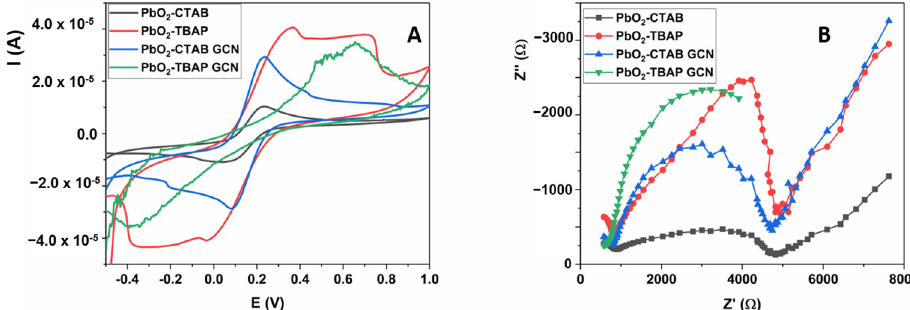
Figure 2. ( A ) CV voltammograms of modified electrodes in Fe 2+/3+ redox couple at the scan rate of 50 mV/s; ( B ) EIS spectra of modified electrodes in Fe 2+/3+ redox couple. Working potential 0.1 V.